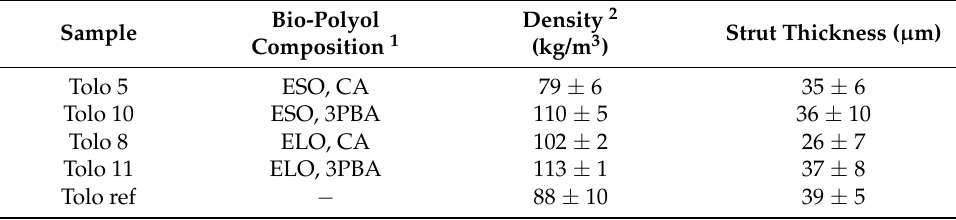
Figure 8. FTIR spectra of the different PUFs. The apparent density of PUFs is reported in Table 4, along with strut thickness. The apparent high density of all PUFs was in the range of 79–113 kg/m 3 , due to low amount of blowing agent. The highest density value was obtained for foams from 3-phenyl butyric acid. Table 4. Density and strut thickness of PU (polyurethane)